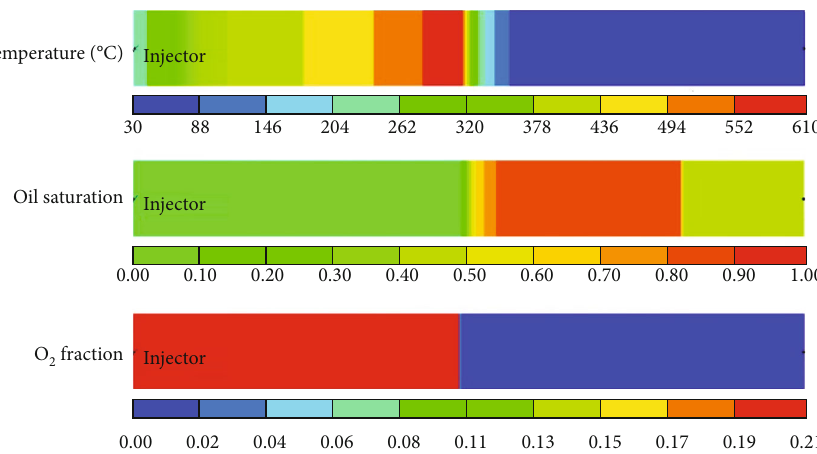
Figure 13: The temperature, oil saturation and O simulation (inject from left, produce from right).